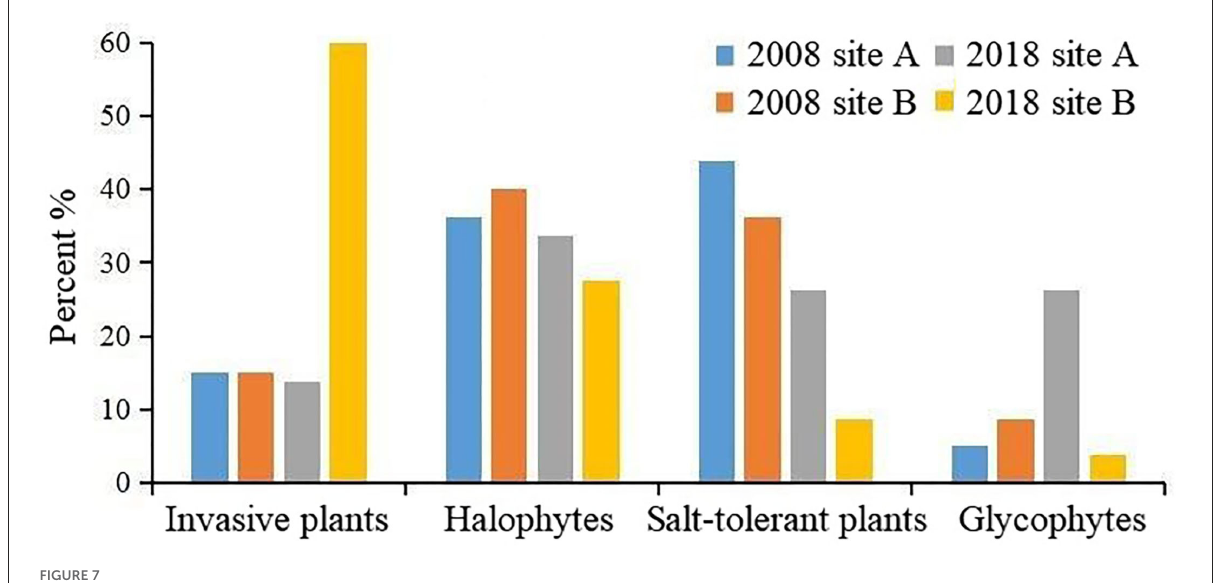
FIGURE7 Changes in the proportion of coastal wetland vegetation